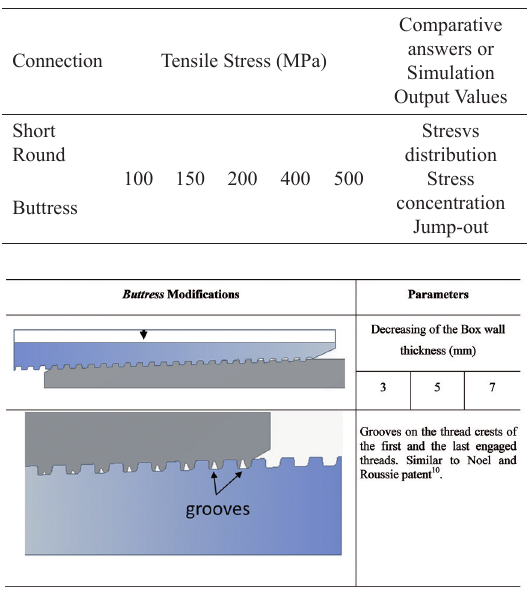
Figure 4: Axisymmetric condition and the boundary conditions of the second stage of the simulation: make-up torque plus crescent tensile stress applied in B. Point A is the symmetry plane with axial displacement set to zero (Y direction). Table 4: Tensile stresses applied to the connections and evaluated output values.